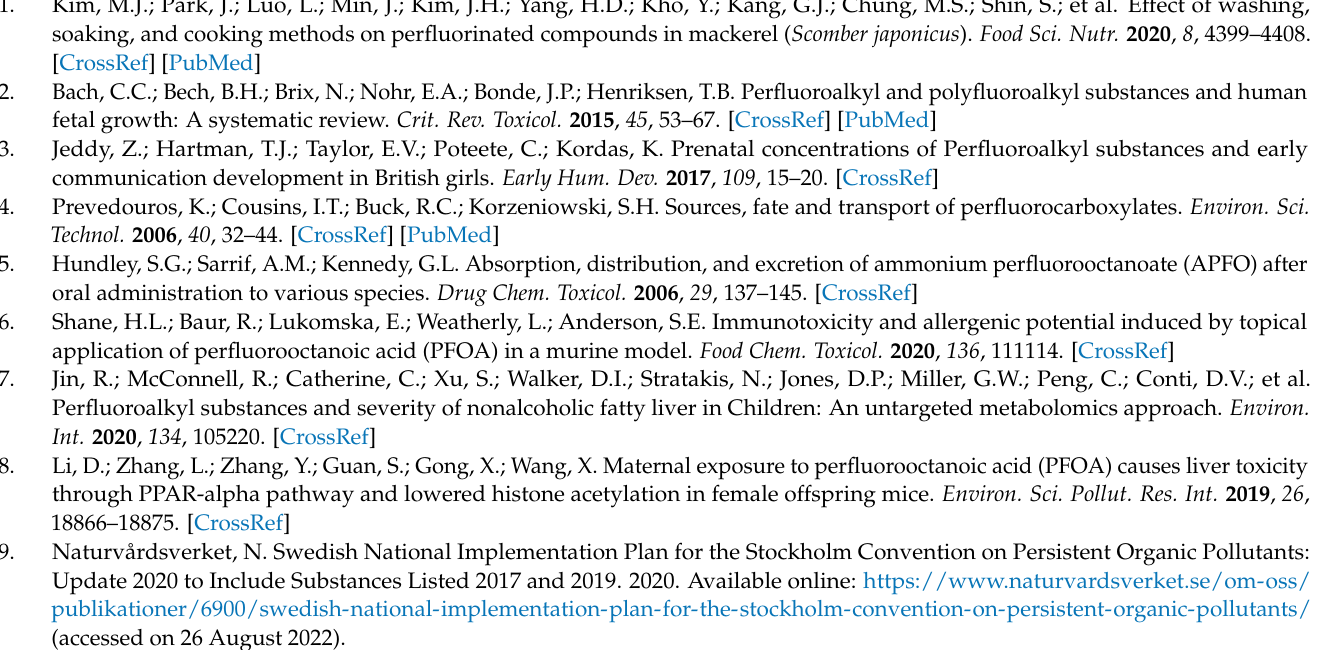
Table S2: Title/abstract screening criteria for the literature search; Figure S1: Overall average effect size; Figure S2: A summary forest plot of effect size values for each